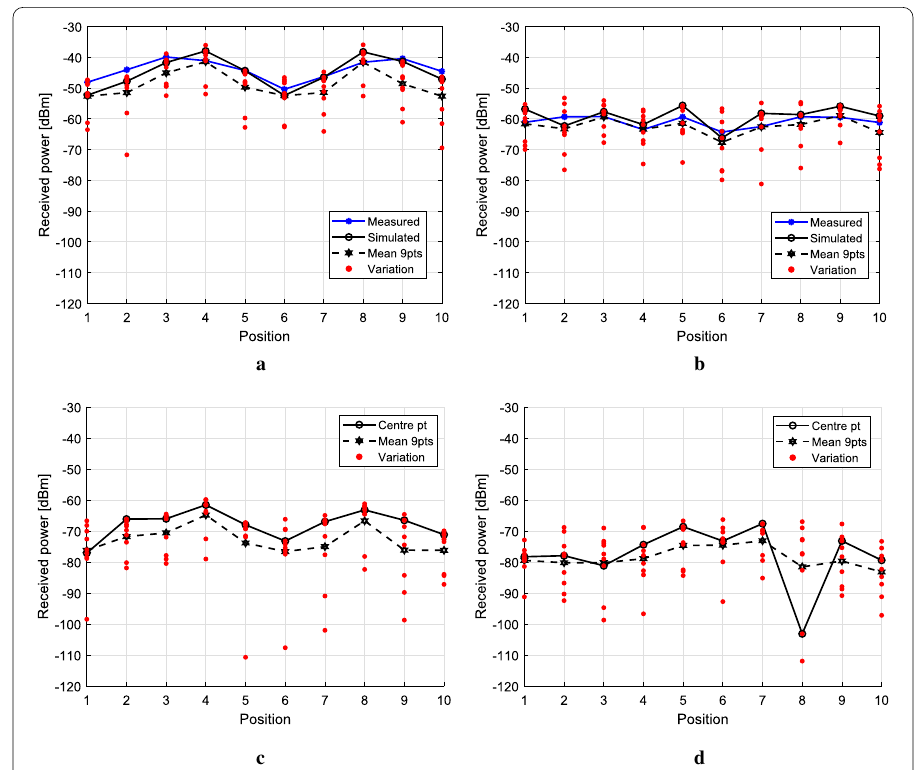
Fig. 7 Received power at receiver positions with, a Tx1-Config1, b Tx2-Config1, c Tx1-Config2 and d